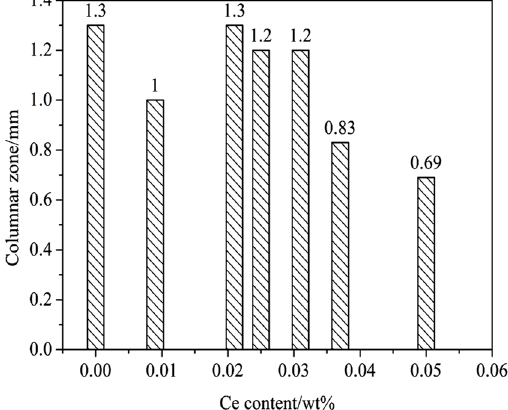
Figure 3. Range of columnar zone versus cerium content in a cast high-manganese austenitic steel, reproduced from Reference [43], with permission of AIS Tech, 2011.